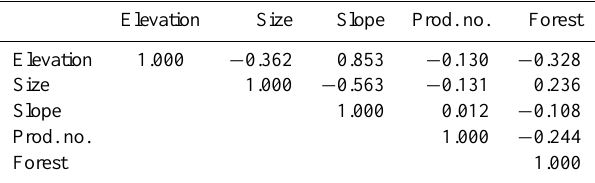
Table 2. Spearman rank correlation coefficients between the catch- ment characteristics from Table 1. All correlations were significant at the 5% level (Prod. no. – productivity number).